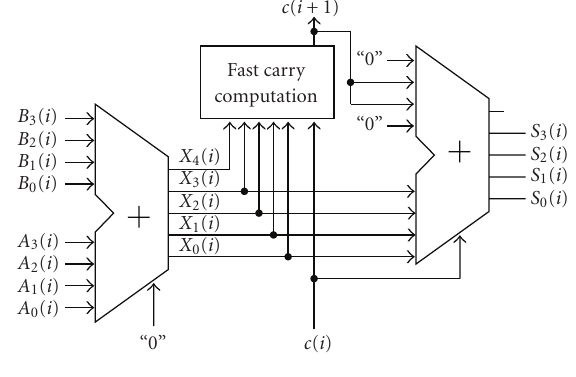
Figure 1: BCD-8421 full adder.